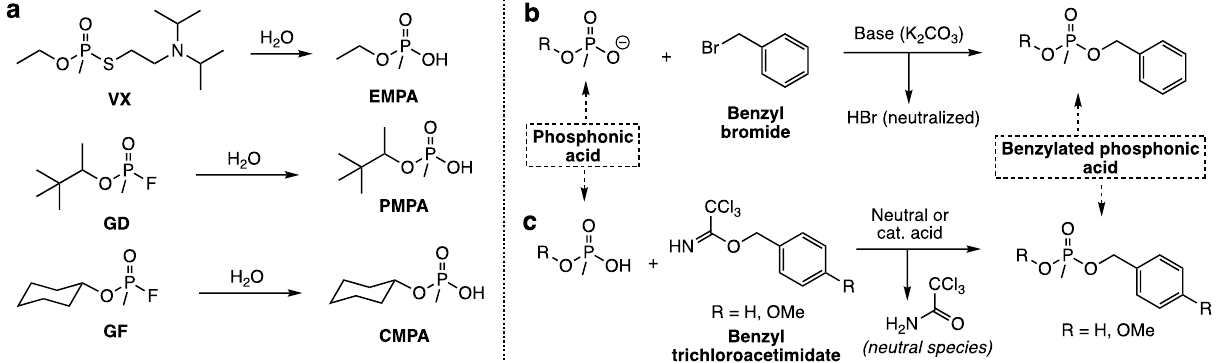
Figure 1. ( a ) Hydrolysis of the organophosphorus-based nerve agents VX, GD and GB to yield ethyl methylphosphonic acid (EMPA), pinacolyl methylphosphonic acid (PMPA) and cyclohexyl methylphosphonic acid (CMPA) respectively. Benzylation approaches for phosphonic acids using ( b ) benzyl bromide in the presence of a base and ( c ) using benzyl and p -methoxybenzyl trichloroacetimidates under neutral, basic or acidic